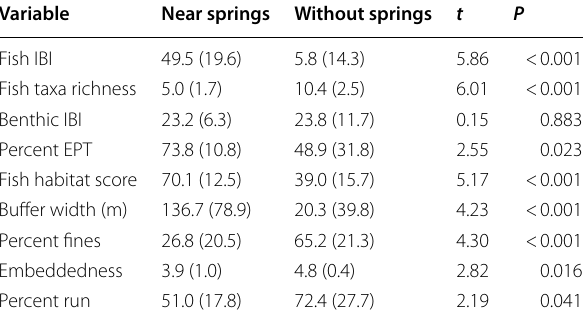
Table 6 Statistical comparisons ( t tests) of biotic indexes and stream habitat variables at sites on the South Fork Whitewater River, Minnesota, USA near springs ( n 10; sites 13 through 22) = and without springs ( n 12; sites 1 through 12) (see Fig. 1 for site =